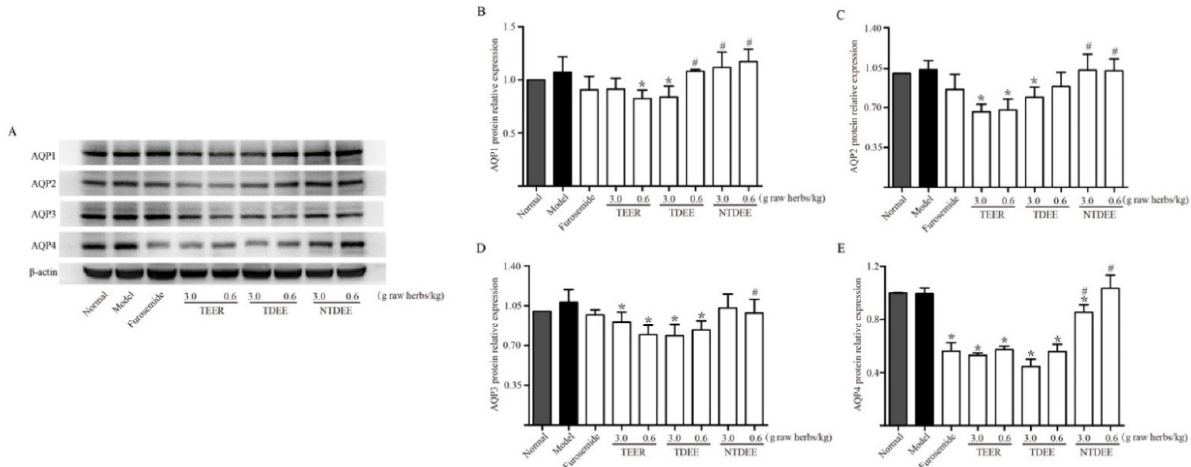
Figure 3. Effects of extracts from the root of Euphorbia ebracteolata Hayata (EER) on aquaporins (AQPs) expression in the kidneys of H22 tumor cell-bearing mice. ( A ) Western blot bands of AQP1, AQP2, AQP3 and AQP4. ( B ) AQP1 protein relative expression. ( C ) AQP2 protein relative expression. ( D ) AQP3 protein relative expression. ( E ) AQP4 protein relative expression. Normal: normal mice treated with blank solvent. Model: H22 tumor cell-bearing mice treated with blank solvent. TEER: total extract of EER; TDEE: total diterpenoids from EER; NTDEE: non-diterpenoid fraction of EER. The data are represented as the mean ± SD, n = 3, * p < 0.05 vs. model group (Mann–Whitney U test); # p < 0.05 vs. TEER group at the same dose (Mann–Whitney U test).